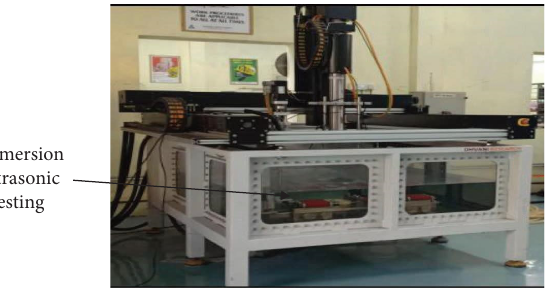
Figure 11: Immersion ultrasonic testing system.